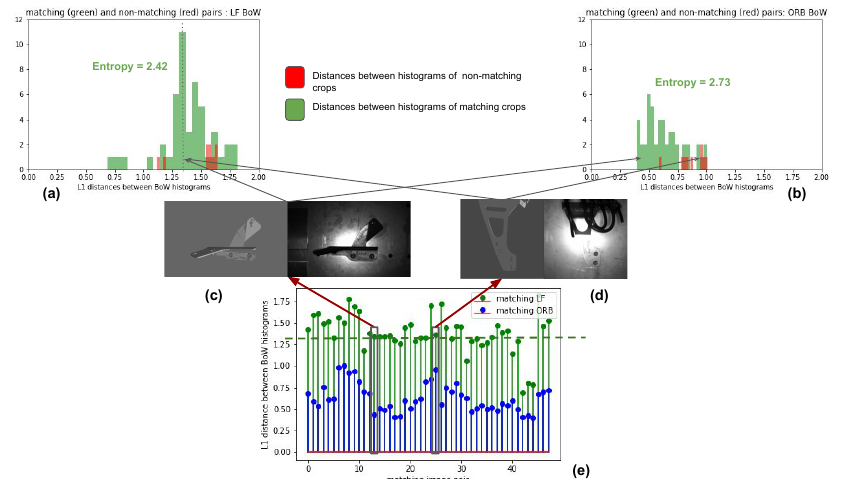
Figure 9. Comparison of image pairs using Bag of Visual Words histograms learned from renders and real images using ORB features and the learned features (LF). ( a , b ) are distributions of L1 distances between BoVW histograms of matching and non-matching image pairs using LF and ORB features respectively. ( c , d ) are matching pairs of rendered and real images. ( e ) is a plot of L1 distances between BoVW histograms of matching image pairs using LF and ORB